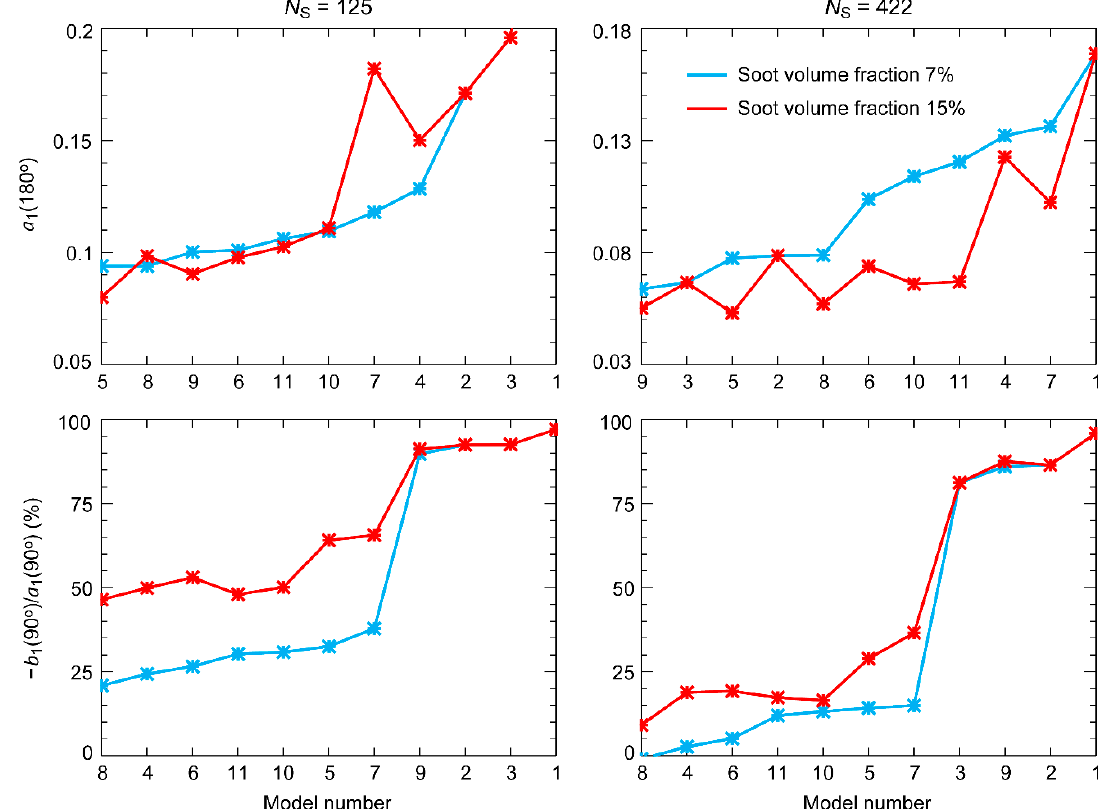
Figure 9. Phase function at Θ = 180° (upper panels) and linear polarization at Θ = 90° (bottom panels) computed at the wavelength λ = 532 nm for all 11 morphological models. In the case of Models 4–11, the blue and red curves represent the results calculated for the soot volume fractions f = 7% and 15%, respectively. The number of soot spherules is N S = 125 (left-hand panels) and 422 (right-hand panels).